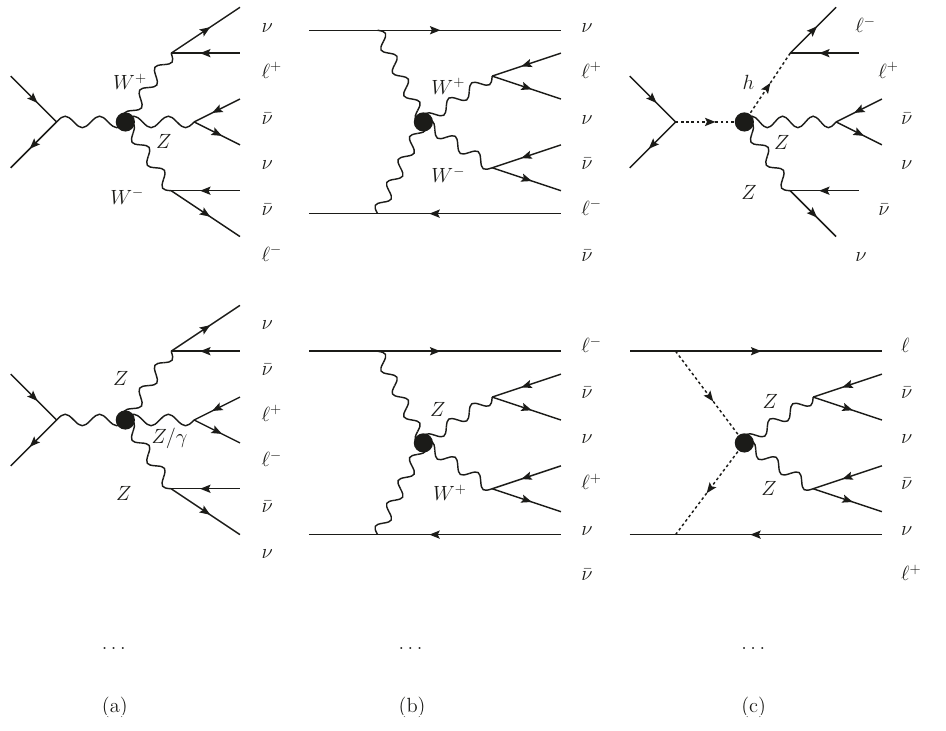
Figure 1 . The tree-level Feynman diagrams of the aQGCs contribution to the process µ + µ − → ‘ + ‘ − νν ¯ ν ¯ ν